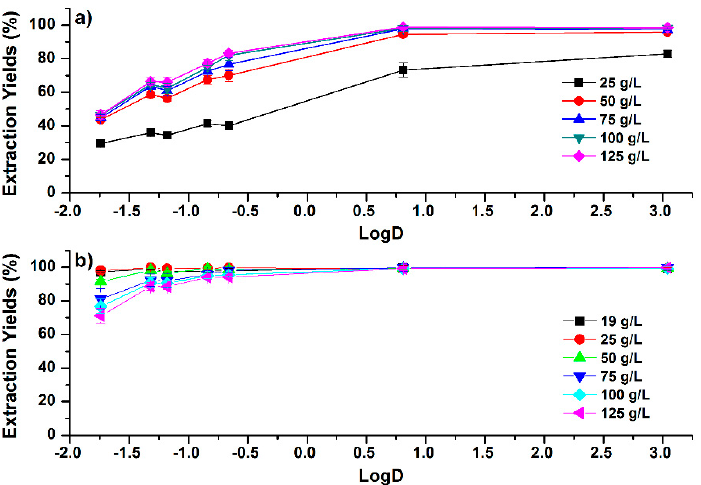
Figure 1. Representative HPLC-DAD chromatogram ( λ = 280 nm) of phenolic compounds in propolis. 1, caffeic acid; 2, p -coumaric acid; 3, isoferulic acid; 4, dimethoxycinnamic acid; 5, cinnamic acid; 6, kaempferol; 7, caffeic acid phenethyl ester.